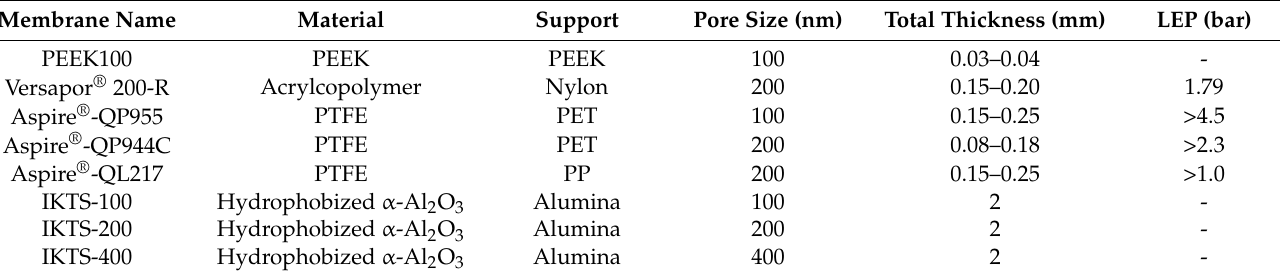
Table 2. Membrane parameters given by